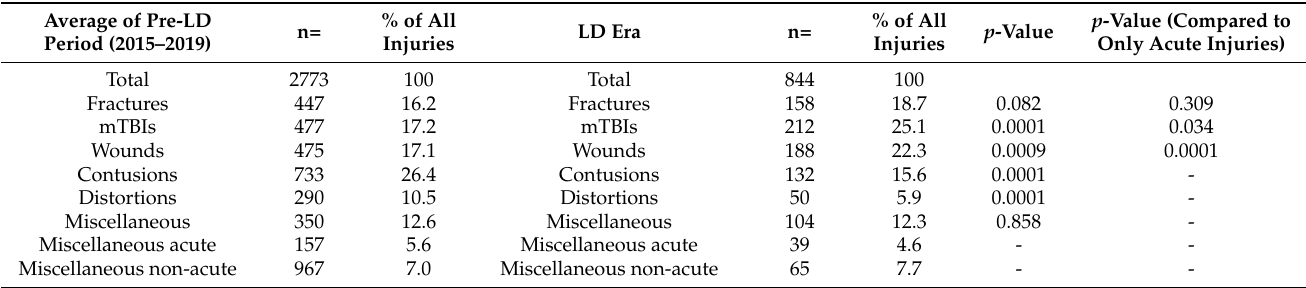
Table 2. Average numbers and percentages of the pre-LD period plus the p -values of each category (pre-LD vs. LD period) in proportion to all